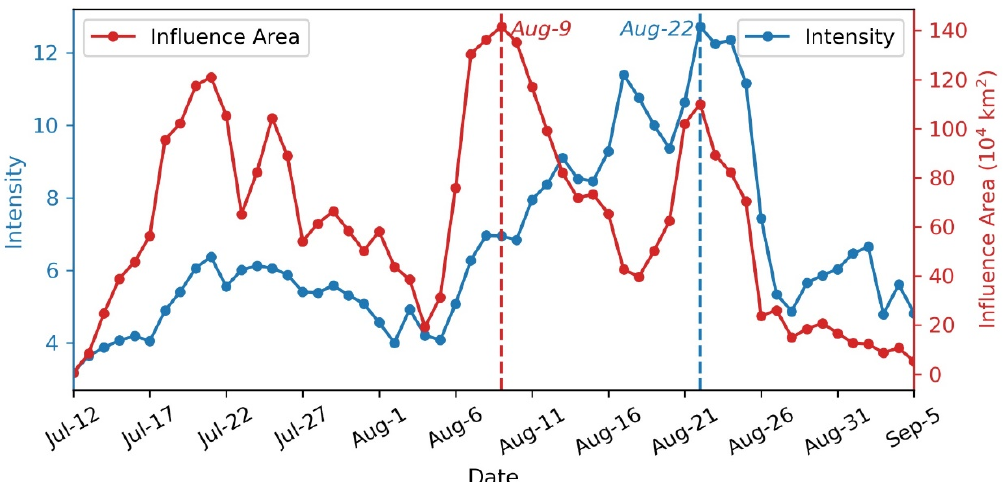
Figure 14. The evolution process and comparison between intensity and influence area for the heatwave event with the longest duration.